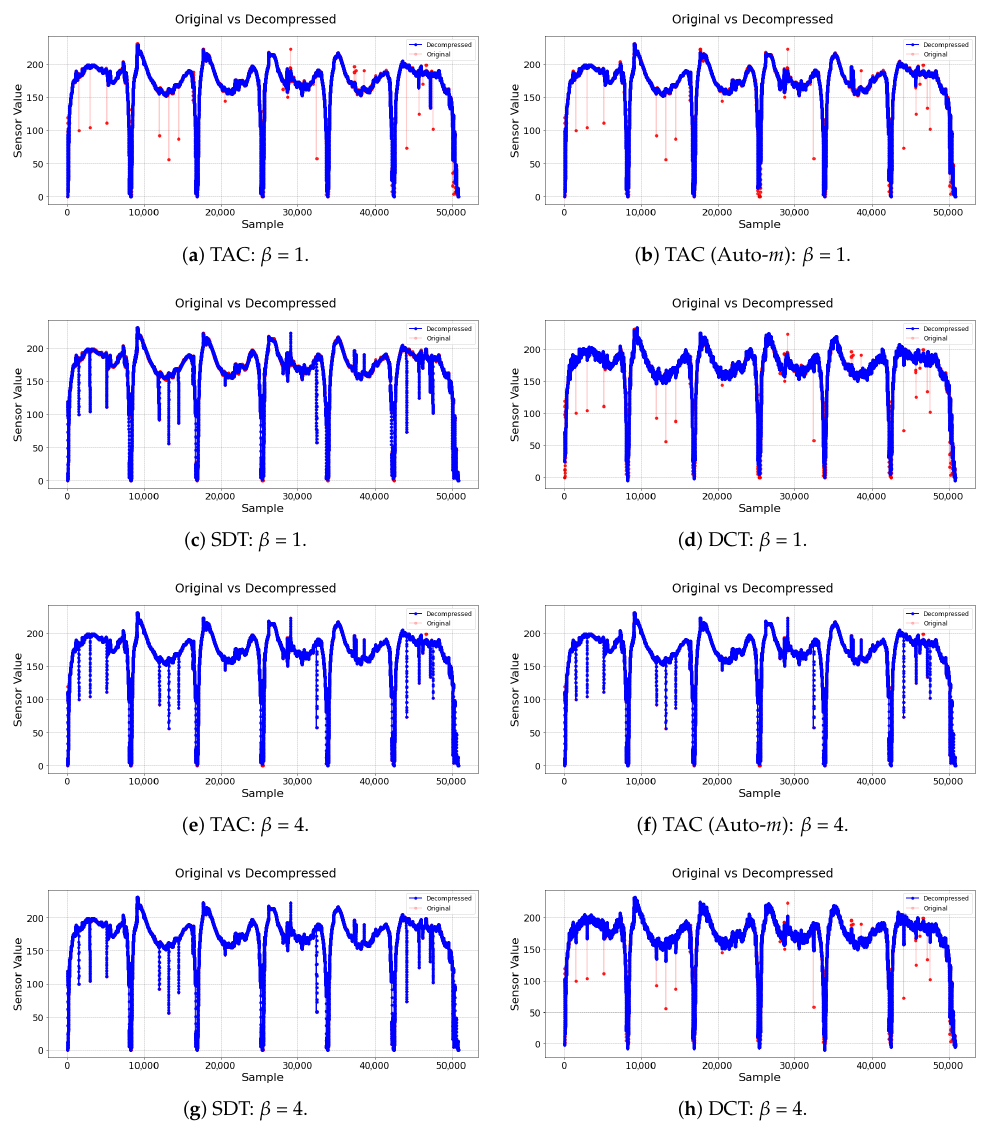
Figure 4. Original and decompressedsignals: Dataset 1.